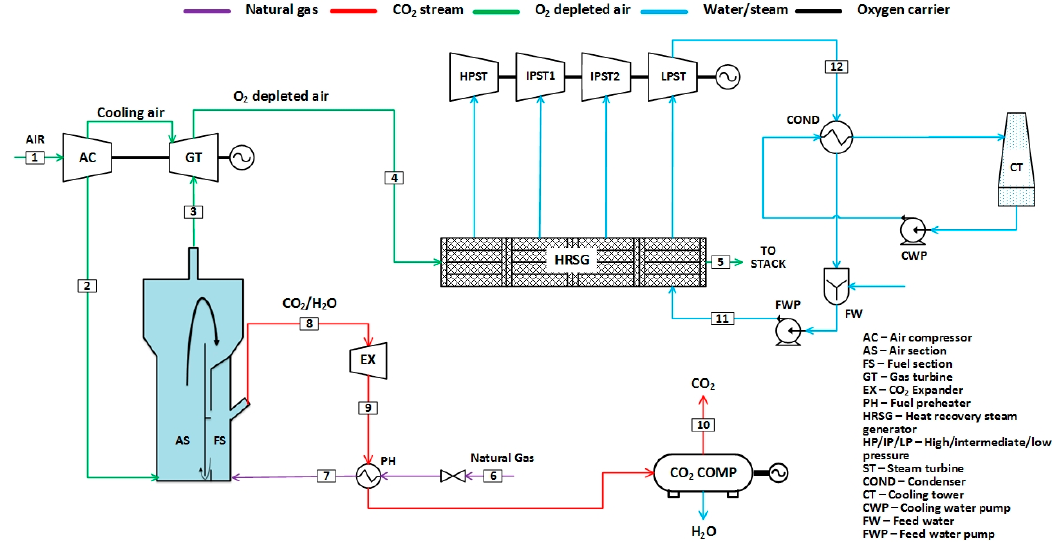
Figure 3. Process flowsheet of the ICR integrated into a combined cycle. It can be noted that the reactor in the flowsheet represents a cluster of ICR reactors and that the outputs from these reactors were combined in stream 3.